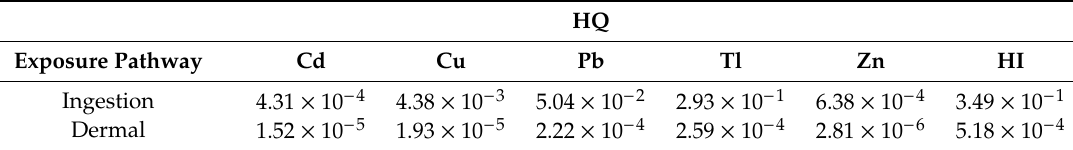
Table 8. Hazard quotients (HQ) and hazard indexes (HI) through soil ingestion and dermal contact by farm workers.